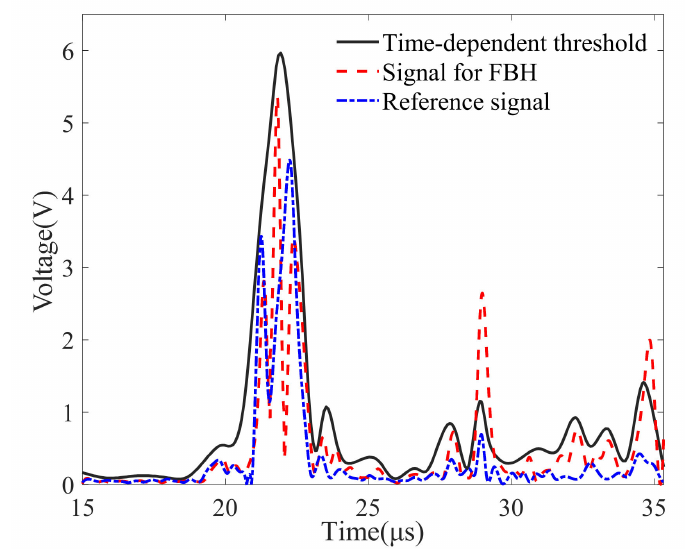
Figure 10. A-wave signals and time-dependent threshold.